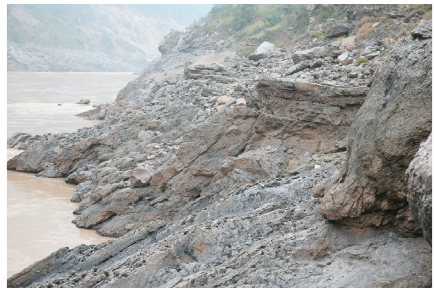
Figure 11: Daomakan landslide